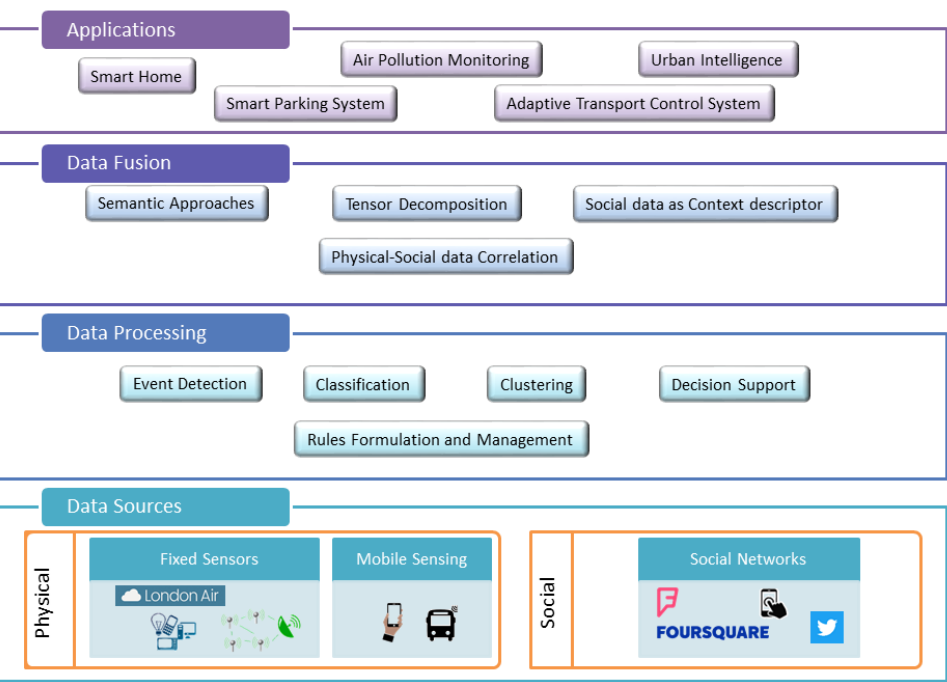
Figure 4. A conceptual framework for CPSS.